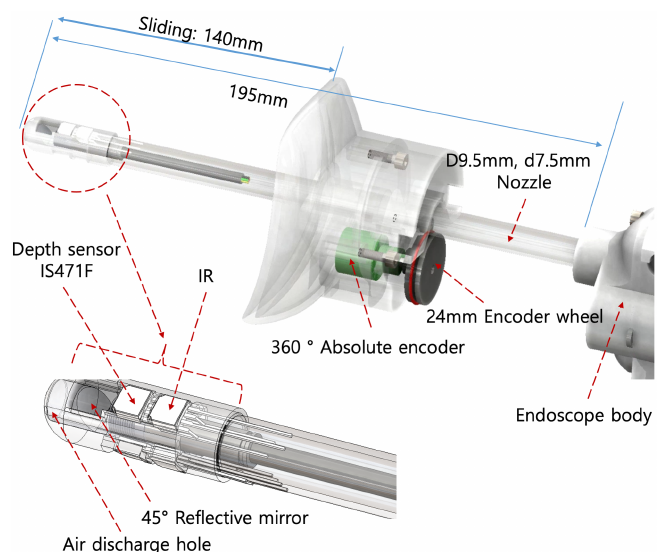
Figure 5. Nozzle design of endoscope.